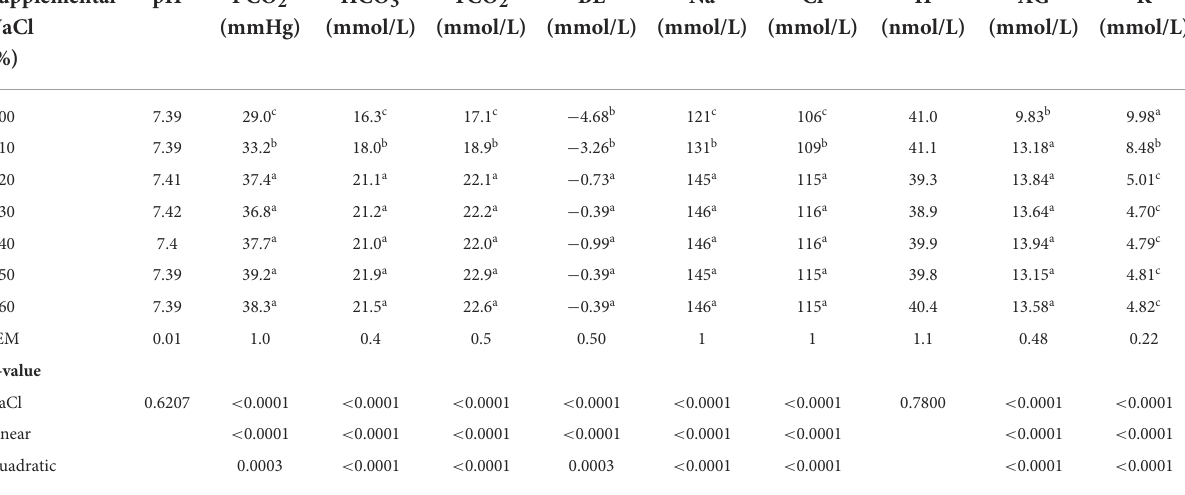
TABLE 4 Effect of dietary NaCl supplemental level on blood gas indices of broilers on day 21 1